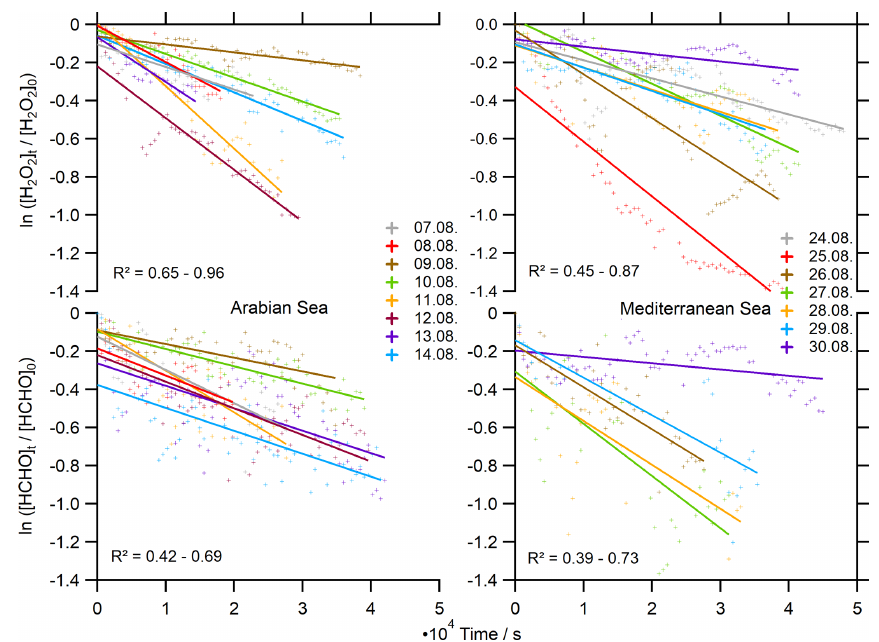
Figure 10. Determination of the deposition rates k dep for H 2 O 2 and HCHO in 10min averages at night ( j NO